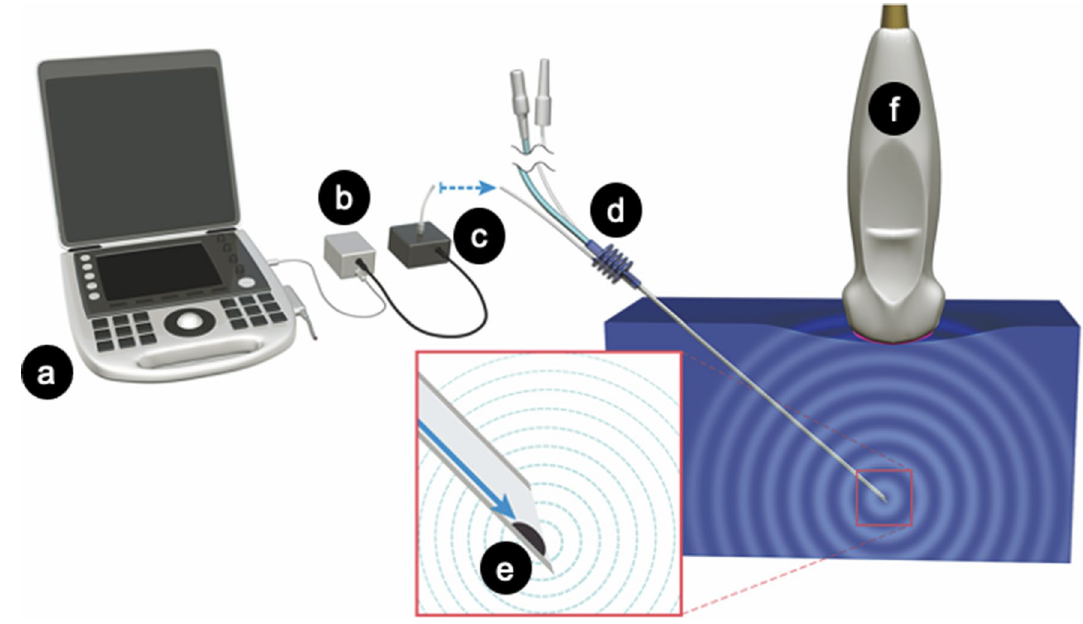
Figure 1. Configuration of the system for photoacoustic needle. Ultrasound machine ( a ) supplies power to an output regulation port ( b ), which controls timing of electric power for generating laser light ( c ). The laser is transmitted through the optical fiber integrated in the lumen of the needle ( d ). The black resin ( e ) absorbs the light, and then converts it to ultrasound by a photoacoustic effect. The ultrasound probe detects the photoacoustic ultrasound. ( a ) Ultrasound machine, ( b ) electrical output regulation port, ( c ) laser light source, ( d ) photoacoustic needle, ( e ) black resin, ( f ) ultrasound